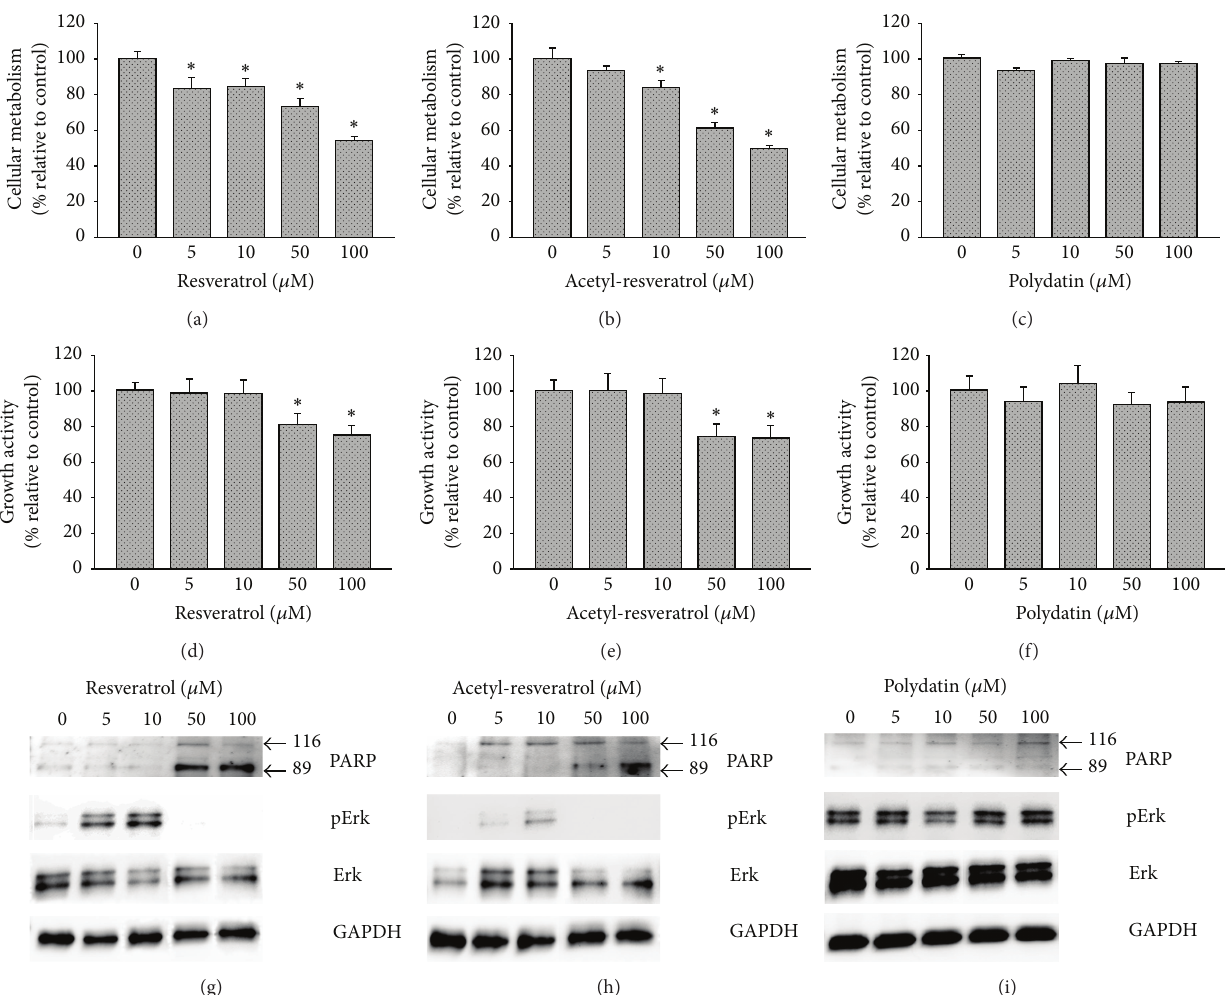
Figure 8: The effects of cellular metabolism, growth activity, and modulation of selective proteins following treatment of resveratrol, acetyl- resveratrol, and polydatin in OVCAR-8 spheroids. Resveratrol (a) and acetyl-resveratrol (b) reduced cellular metabolism in a dose-dependent manner. Higher concentrations of both these compounds also reduced growth activity (d and e). Polydatin showed limited effects (c and f). Both resveratrol (g) and acetyl-resveratrol (h) induced the increased expression of 89kDa PARP-1. The activation of Erk was increased following 5 and 10 𝜇 resveratrol and acetyl-resveratrol exposure. ∗ refers to statistically significant as 𝑝 value less than 0.05 compared to the